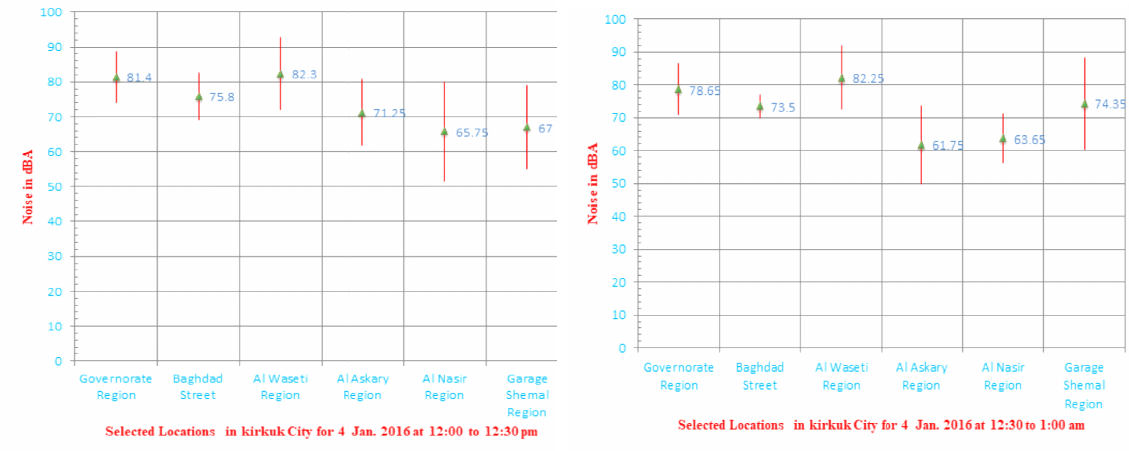
Fig. 11. Max , Min and Average Hourly Noise Distribution for the traffic flow 4 Jan. 2015 Kirkuk City.